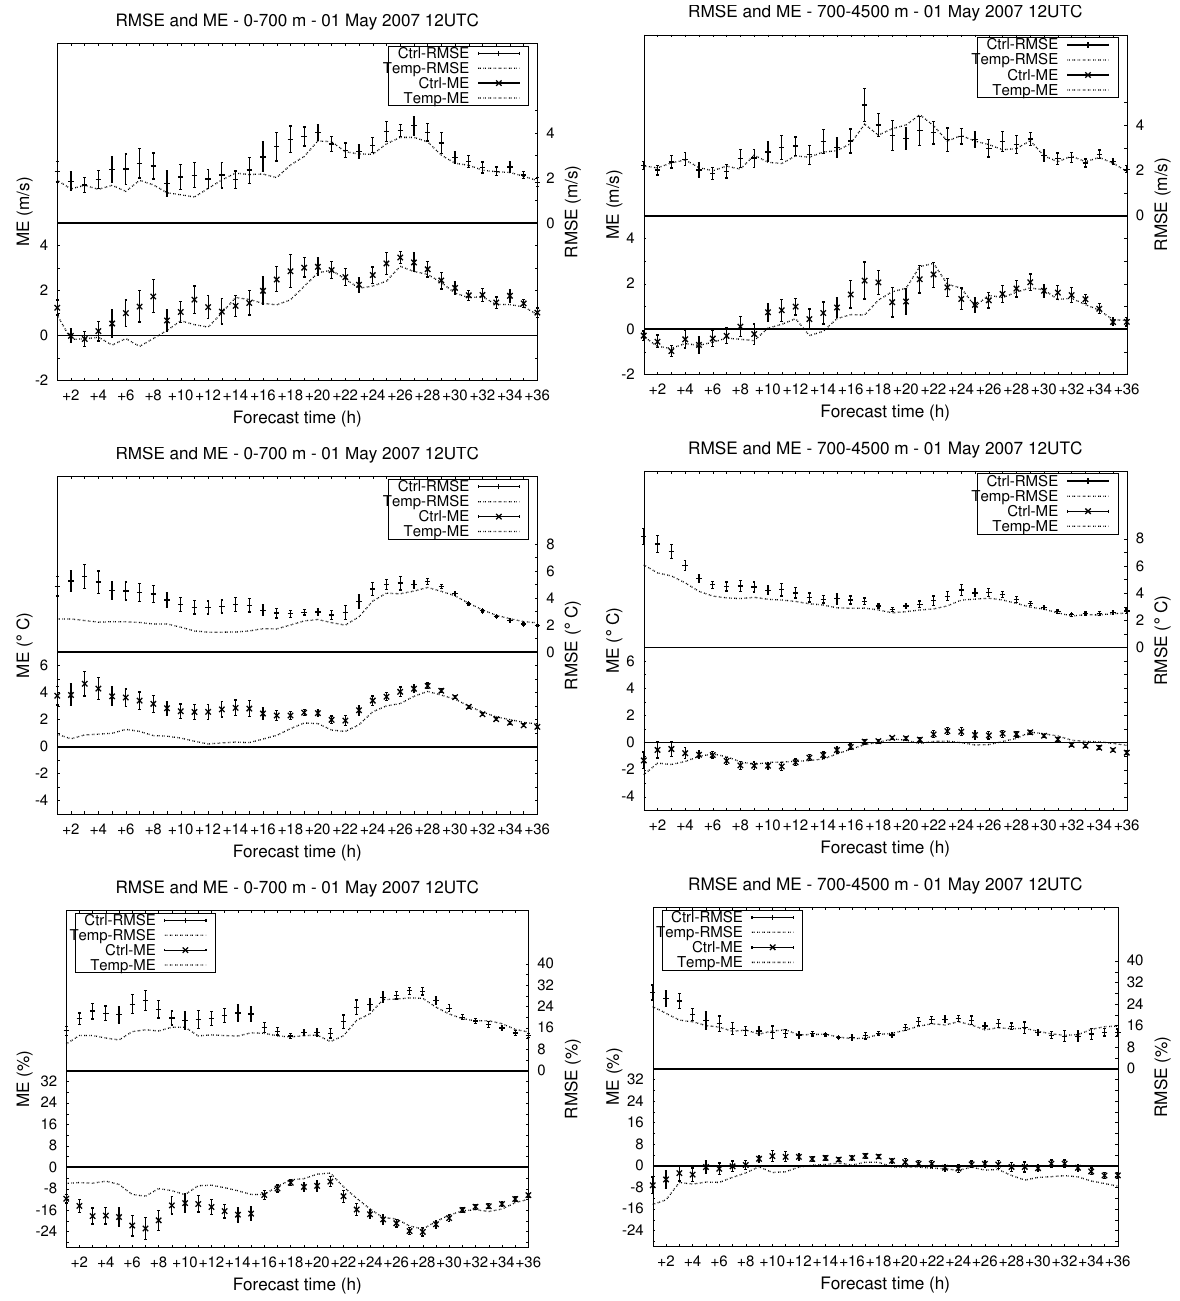
Fig. 7. RMSE and ME for the May 2007 case, over the plains (left) and over the mountains (right); wind intensity (upper panels), temperature (middle panels) and relative humidity (bottom panels). The dots represent the Ctrl run with the significance bar and the dotted line represents the Temp run.